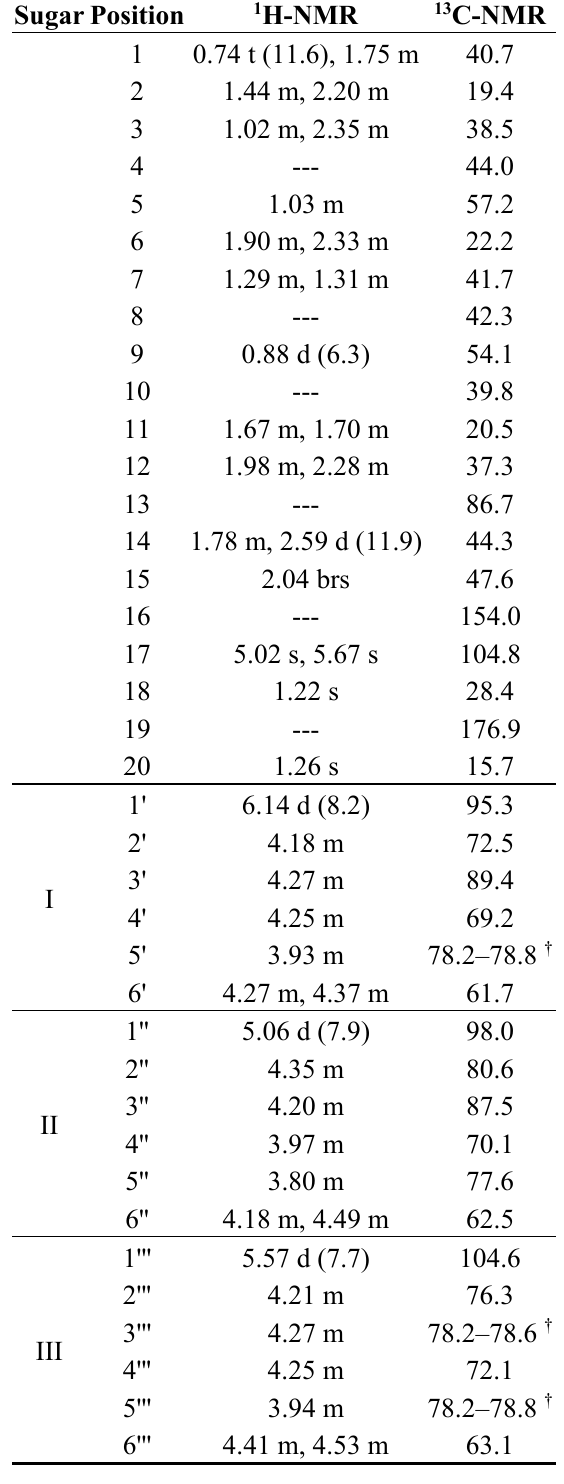
Table 1. 1 H- and 13 C-NMR (500 and 150 MHz, pyridine- d 5 + TMS), assignments of the rebaudioside I ( 5